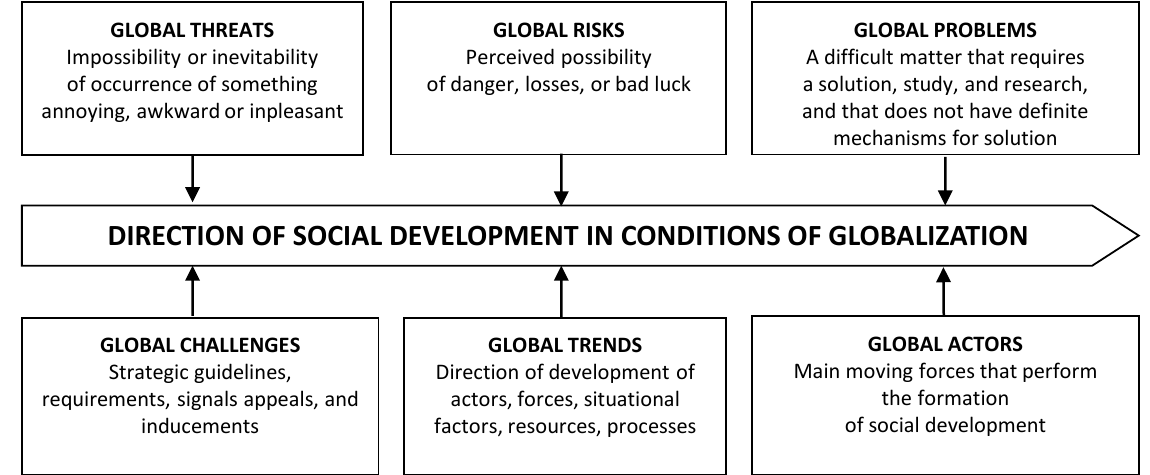
Figure 1. Global factors influencing the direction of social